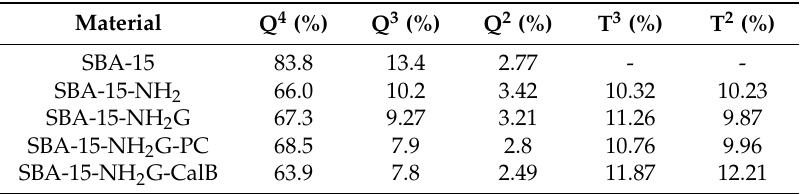
Table 2. Relative peak area in the 29 Si NMR